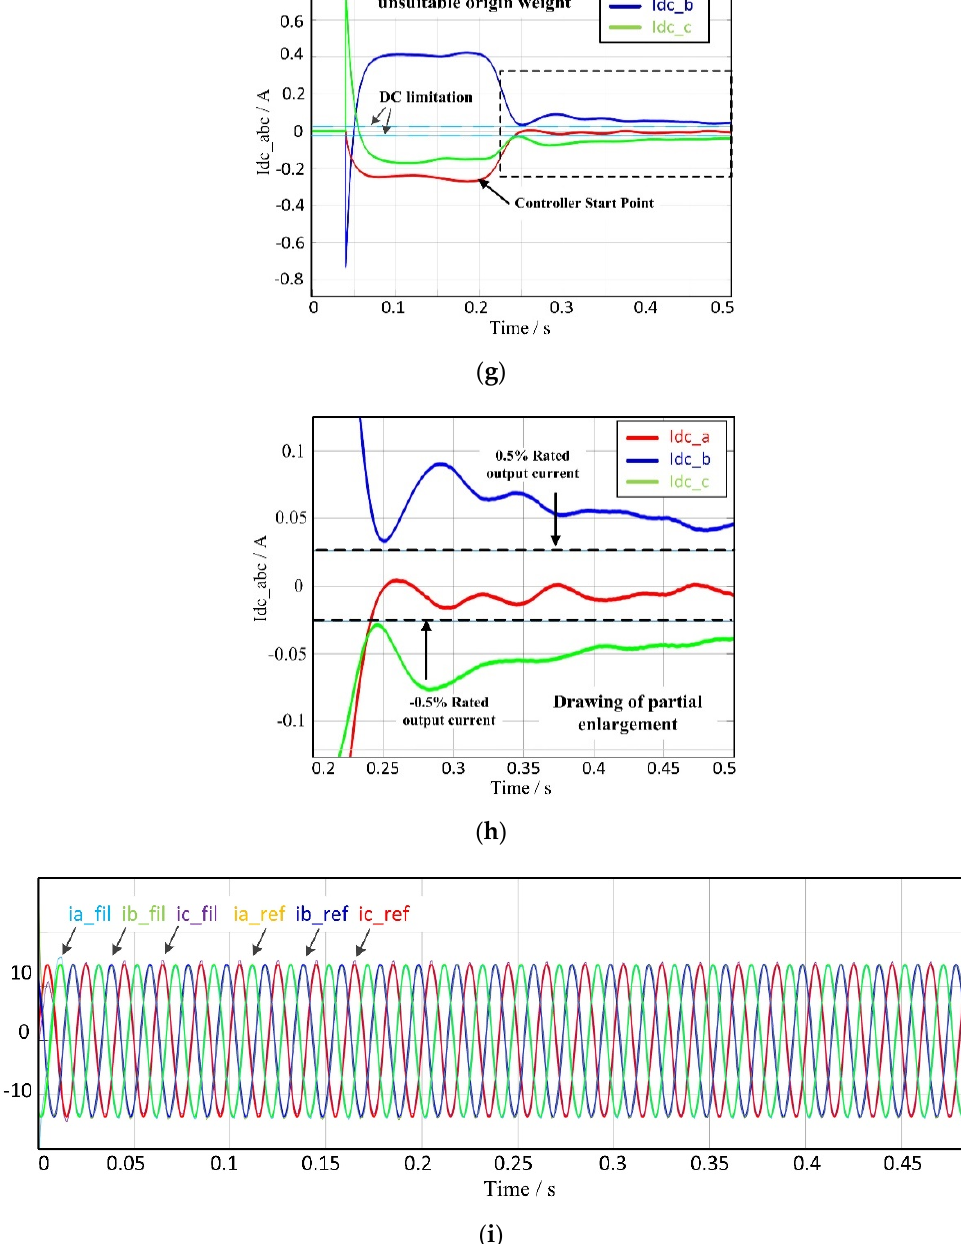
Figure 5. Comparison of the BP-PID schemes with different initial weights in the BP neural network. ( a ) The waveforms of the DC current based on the GA-BP-PID scheme. ( b ) A drawing of the partial enlargement of the dotted line in (a). ( c ) The grid current based on the GA-BP-PID scheme. Similarly, ( d ), ( e ), and ( f ) show the waveforms of the DC current, a drawing of the partial enlargement, and the grid current based on the BP-PID scheme using the reference weight, respectively. ( g ), ( h ), and ( i ) show the waveforms of the DC current, a drawing of the partial enlargement, and the grid current based on the BP-PID scheme using improper weights, respectively.